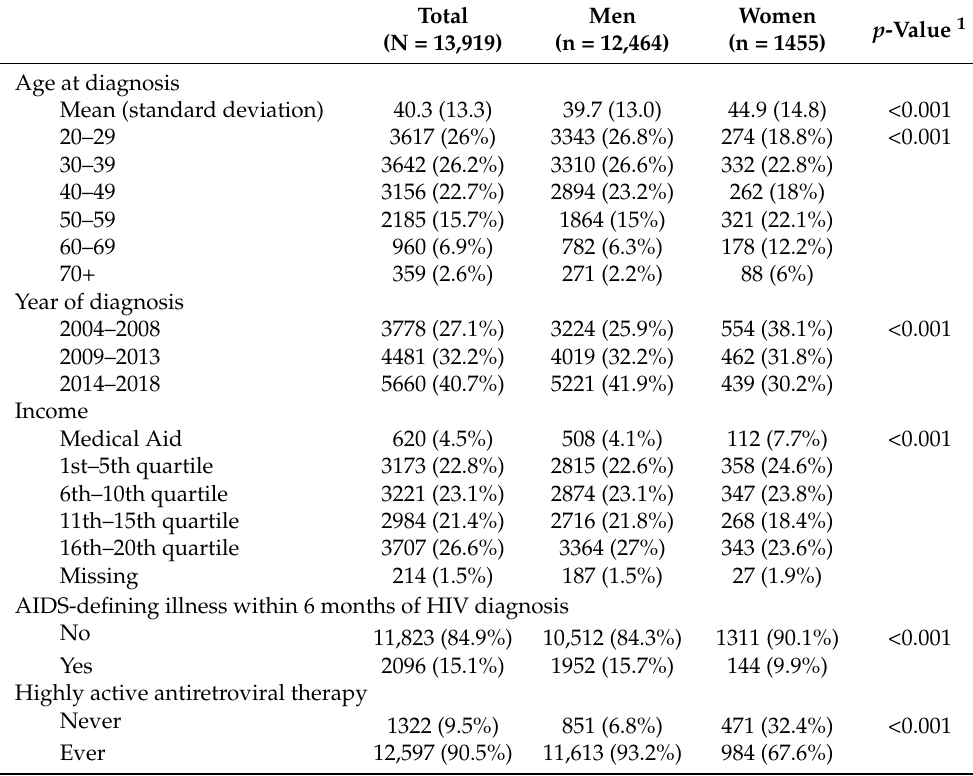
Table 1. Characteristics of human immunodeficiency virus (HIV)-infected people in Korea,